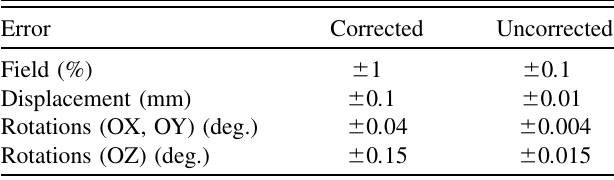
TABLE XIV. The amplitudes of errors for the magnetic octu- poles.